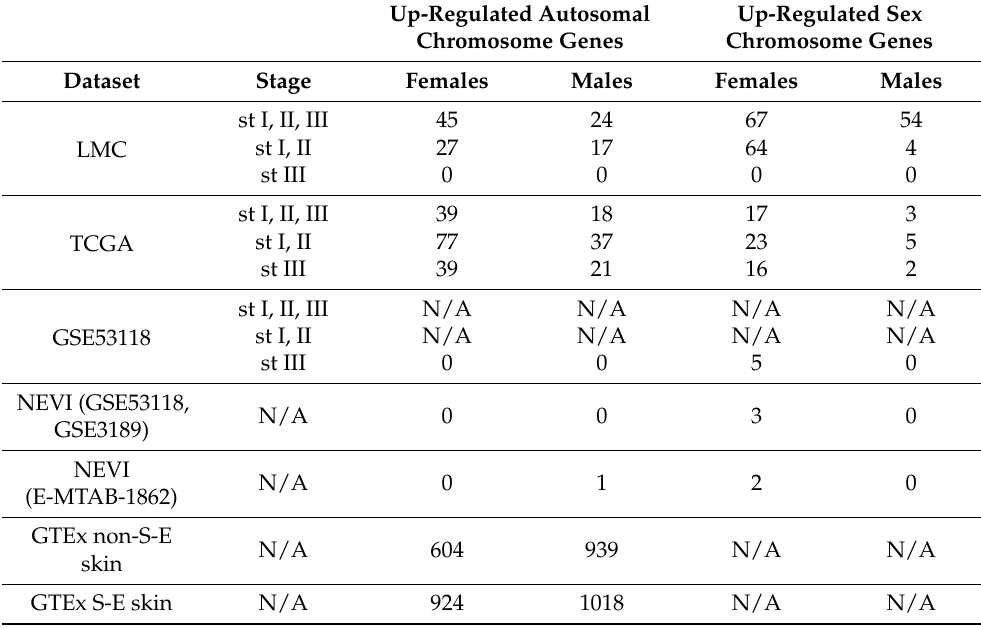
Table 5. Up-regulated autosomal and sex chromosome genes between females and males discovered by the class comparison analysis on all datasets. Melanoma gene expression datasets (LMC, TCGA, GSE53118) were further classified according to